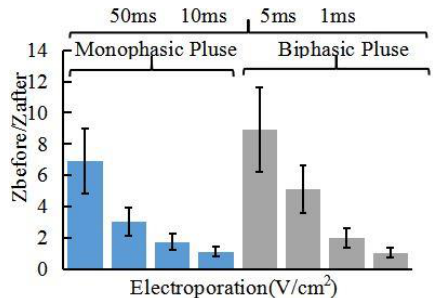
Figure 8. Effect of pulsed-monophasic and pulsed-biphasic electric waveform of electroporation on the ratio of pre-experimental to post-experimental skin impedance ( Z before / Z after ). All skin impedance measurements were conducted at 100 Hz. For the electroporation setting, they all have the number of pulses per second of 10 and the electric field strength of 40 V/cm 2 .